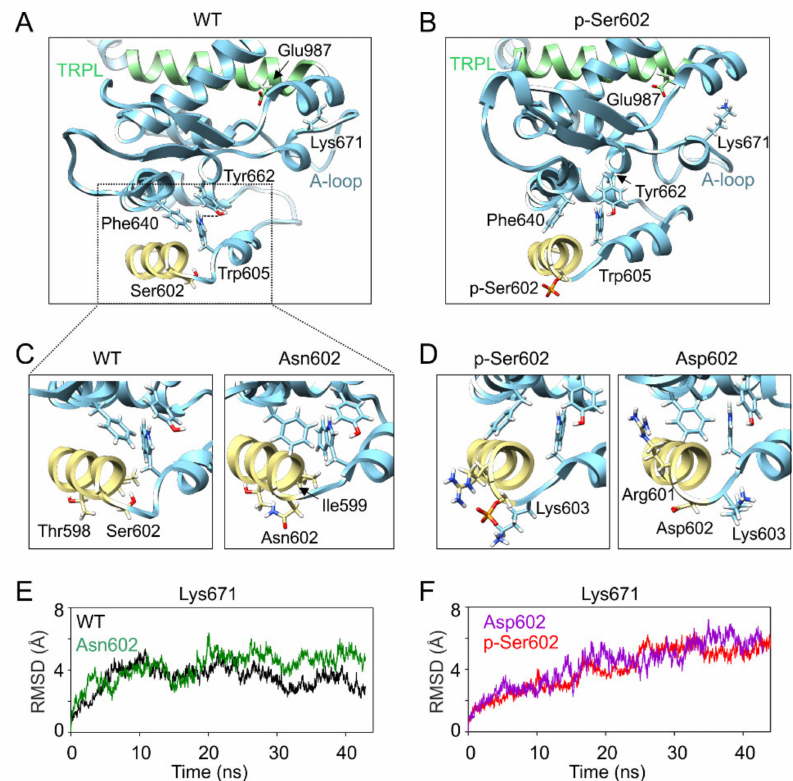
Figure 4. MD simulations indicate possible structural changes induced by modification at Ser602. ( A , B ) Close up view of the cluster of bulky amino acids Phe640, Trp605, and Tyr662 (chain B) through which the signal from Ser602 can be transduced to the activation loop (A-loop). Distances between Trp605 and Tyr662 shown in Supplementary Figure S2 were measured as indicated by dashed line in A. ( C , D ) Close up view of the local conformations of the outer helix of ankyrin repeat 16 obtained from MD simulations of the indicated constructs. ( E , F ) Time course of the average root mean square deviation (RMSD) values for Lys671, measured from the indicated TRPA1